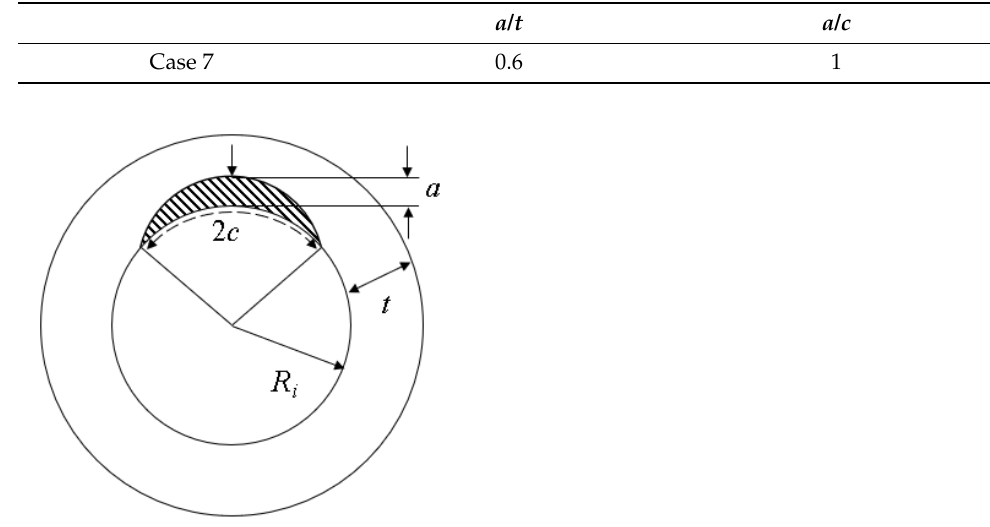
Figure 9. Schematics of pipe with circumferential semi-elliptical inner surface crack.